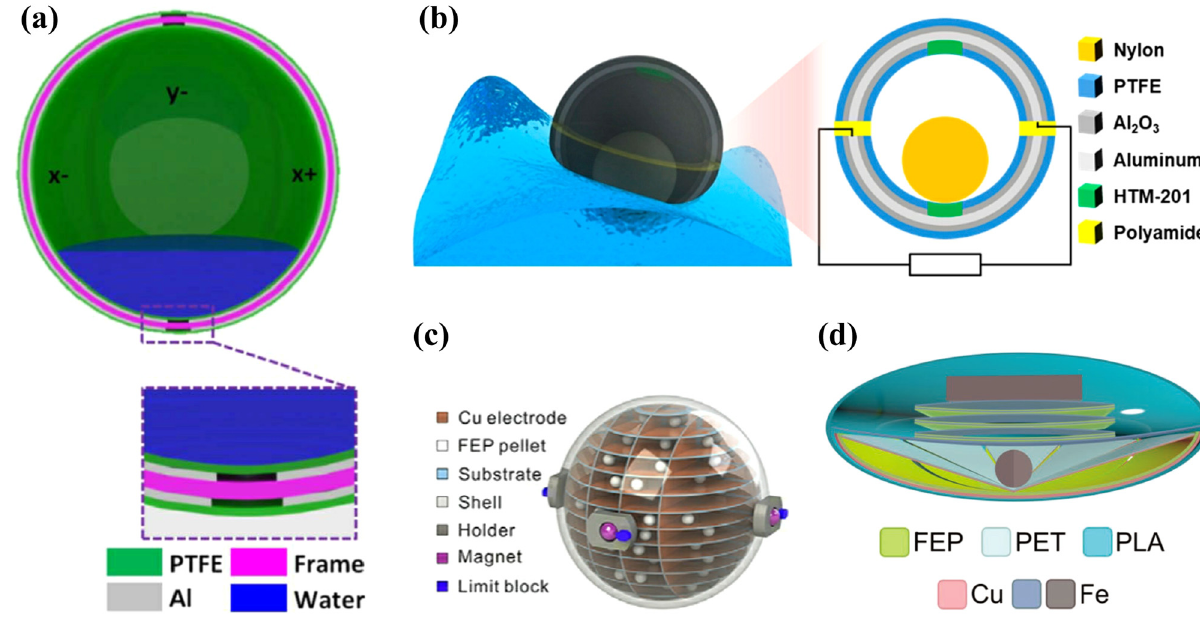
Figure 4: ( a ) Symmetrical 3D spherical water - based triboelectric nanogenerator ( SW - TENG ) structure diagram [ 45 ] , ( b ) spherical hybrid TENG ( SH - TENG ) structure diagram [ 46 ] , ( c ) spherical multilayer TENG [ 55 ] , and ( d ) oblate double - layer TENG [ 56 ]